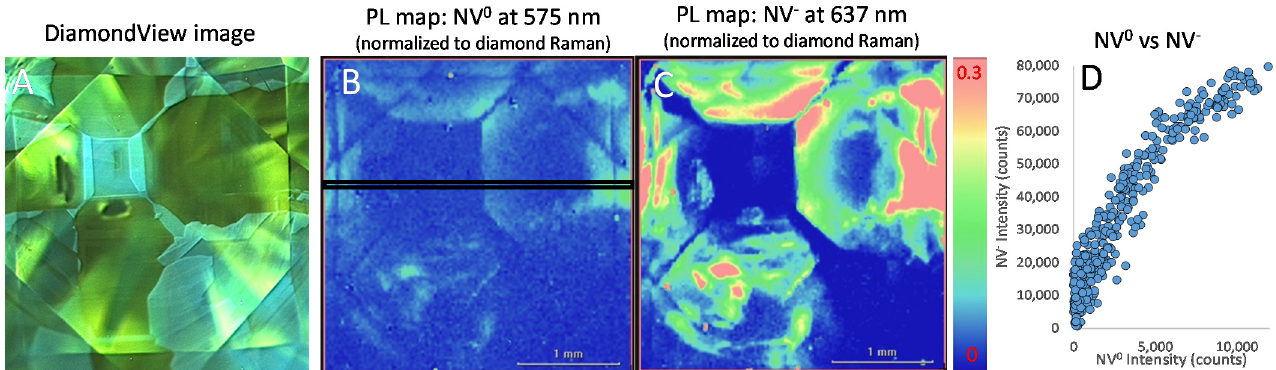
Figure 13. ( A ) A 0.46 ct Fancy Vivid yellow HPHT-grown diamond is illuminated by the DiamondView microscope, showing the various intensities and colors of fluorescence across the growth sectors. ( B ) The PL map for the neutral nitrogen-vacancy (NV 0 ) center—ZPL = 575 nm; ( C ) PL map for the negatively charged nitrogen-vacancy (NV − ) center—ZPL = 637 nm; ( D ) Plot of the values for NV 0 vs. NV − across the region indicated by the black box in ( B ). It shows a consistent ratio between these two centers across the growth sectors, thus providing more information than can be determined from a DiamondView image alone.